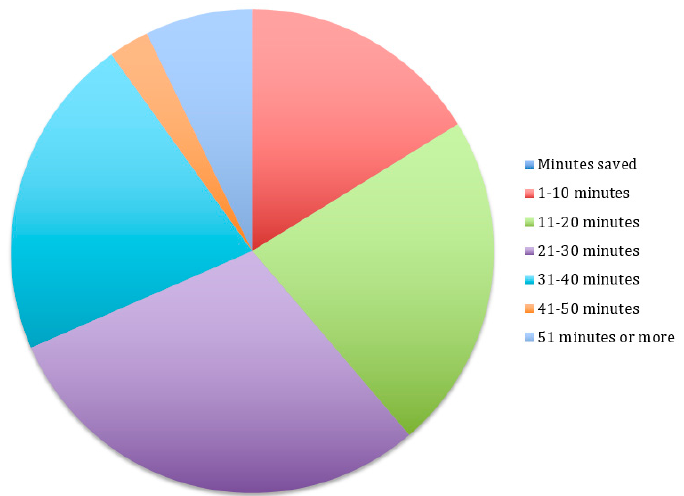
Figure 1. Student reports of the number of minutes saved in every 3 h appointment after implementation of the Faculty Request System (FRS).